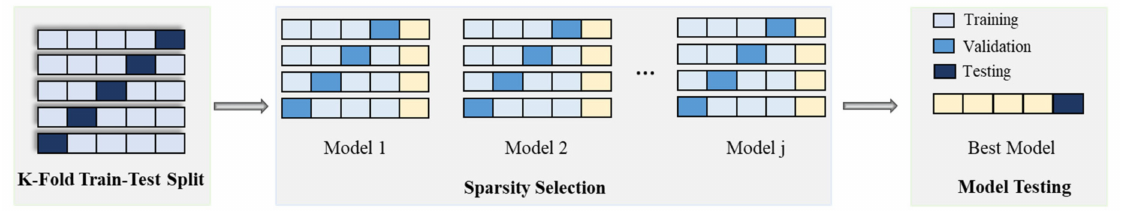
Figure 8. Indication of K-fold cross-validation